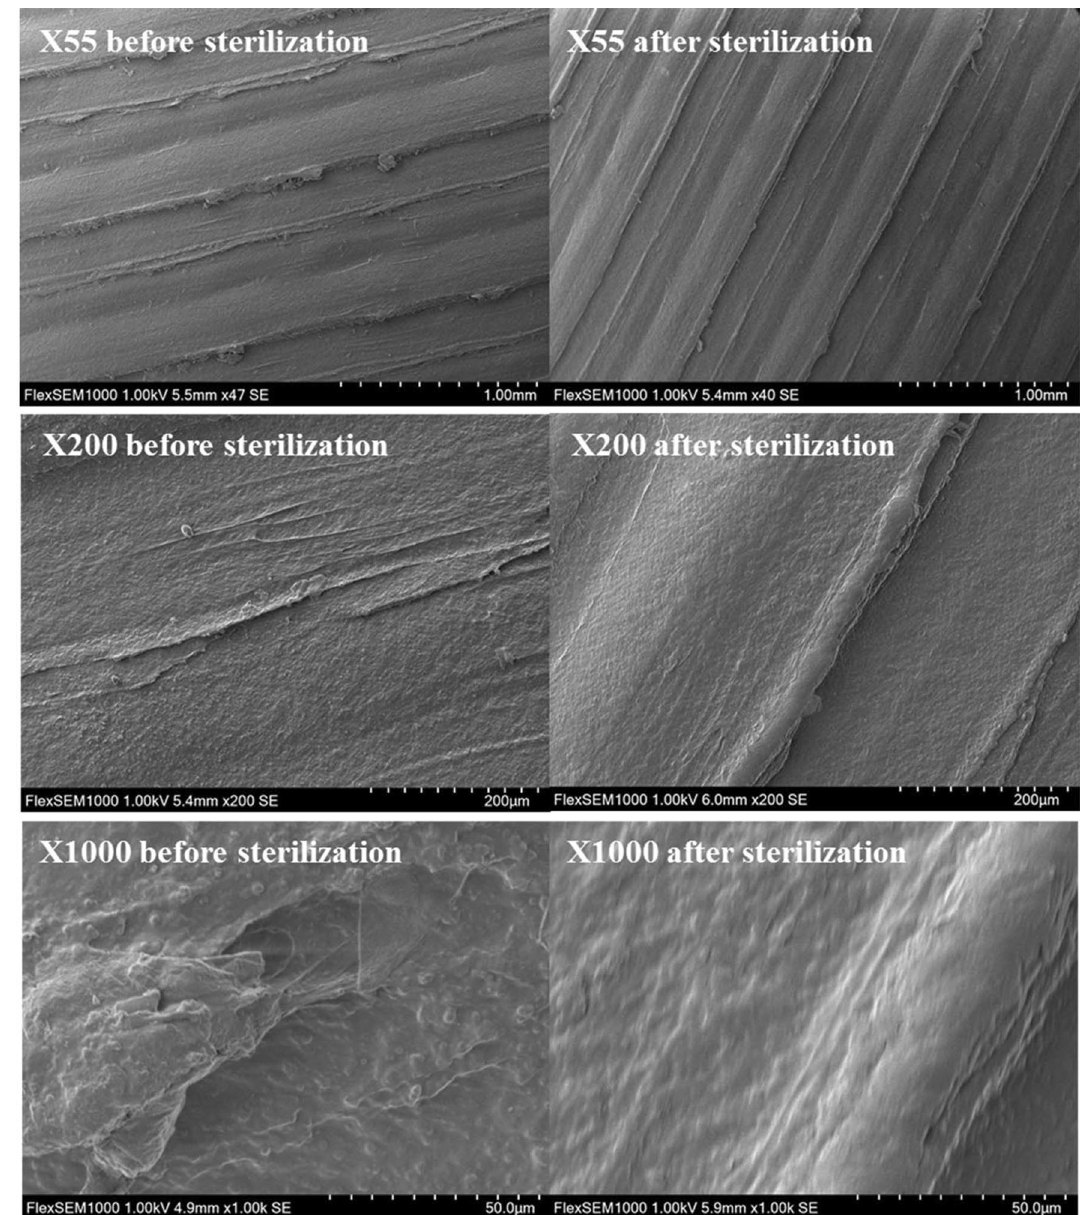
Figure 4. After sterilization (right side), surface observe with SEM were smother as before, with some few topography